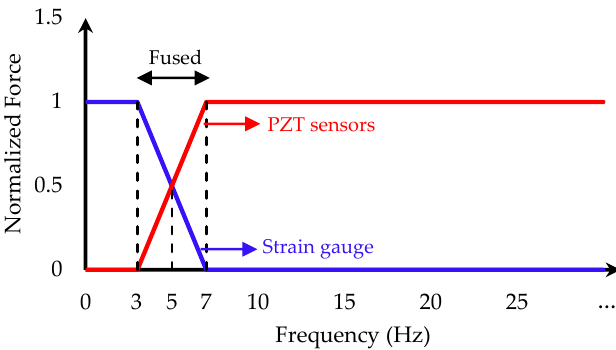
Figure 20. The effects of cutting forces on the clamping force. Figure 20. The e ff ects of cutting forces on the clamping force.